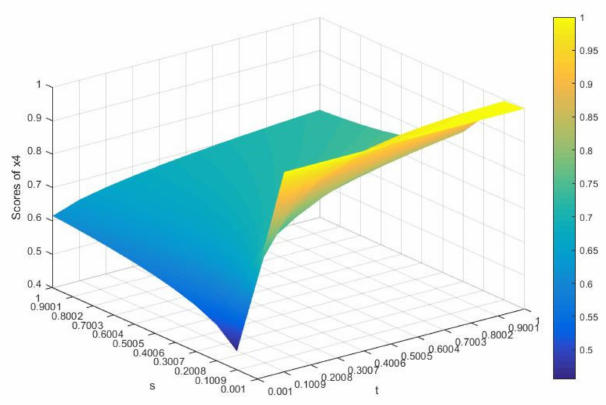
Figure 12. Scores of x 4 obtained by the IFTPGWHM ( t , s ∈ [ 0.001,1 ] ).